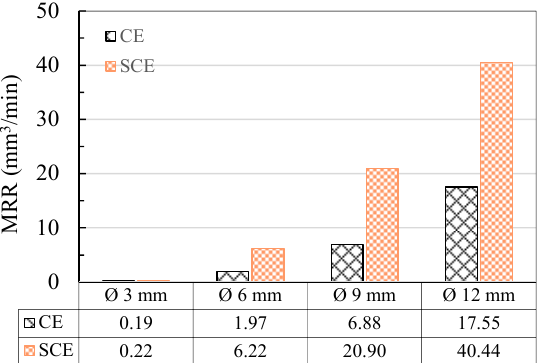
Figure 6. Material removal rate of holes drilled with the conventional electrode (CE) and the step cylindrical electrode (SCE).